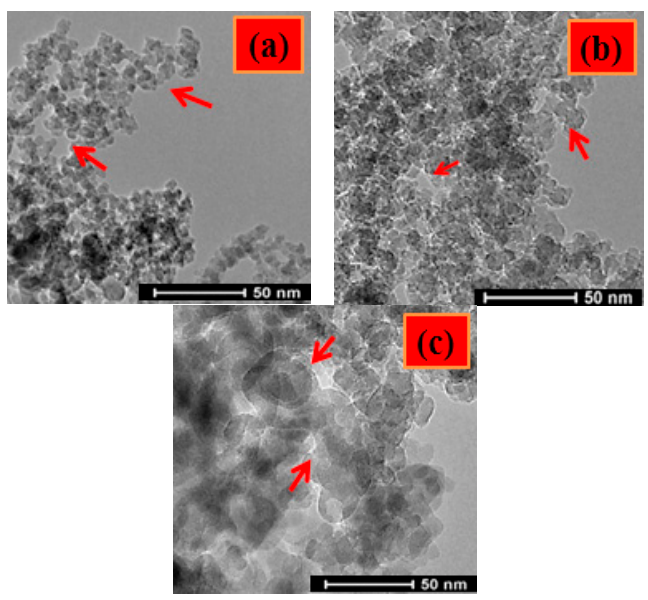
Figure 8. Transmission electron microscopy (TEM) images of ( a ) bare fumed silica; ( b ) silicas modified with mixtures of PDMS-20/DEC and ( c ) neat PDMS-20.